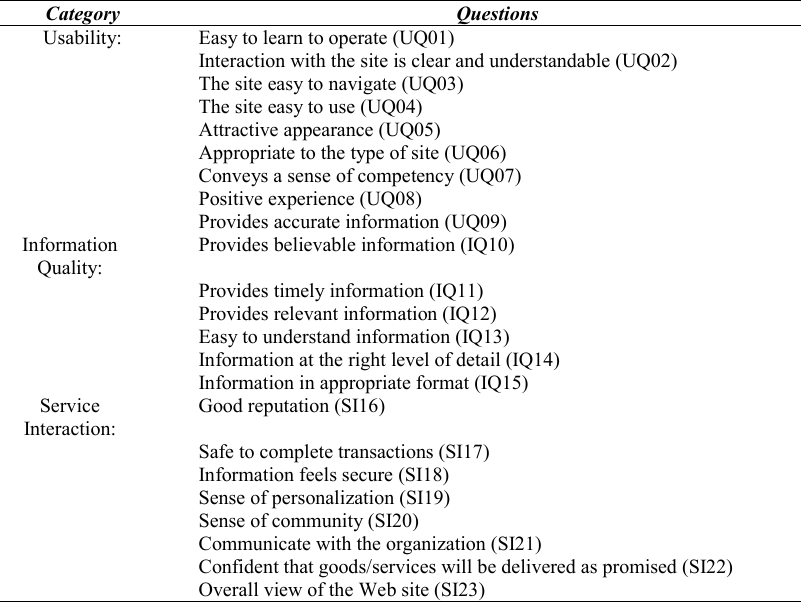
TABLE 1 WEBQUAL 4.0 INSTRUMENTS [9, 20].